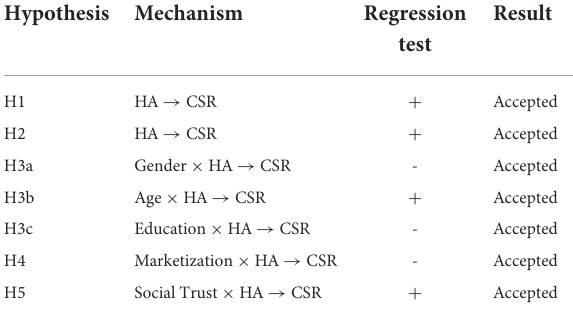
TABLE 13 Results of the